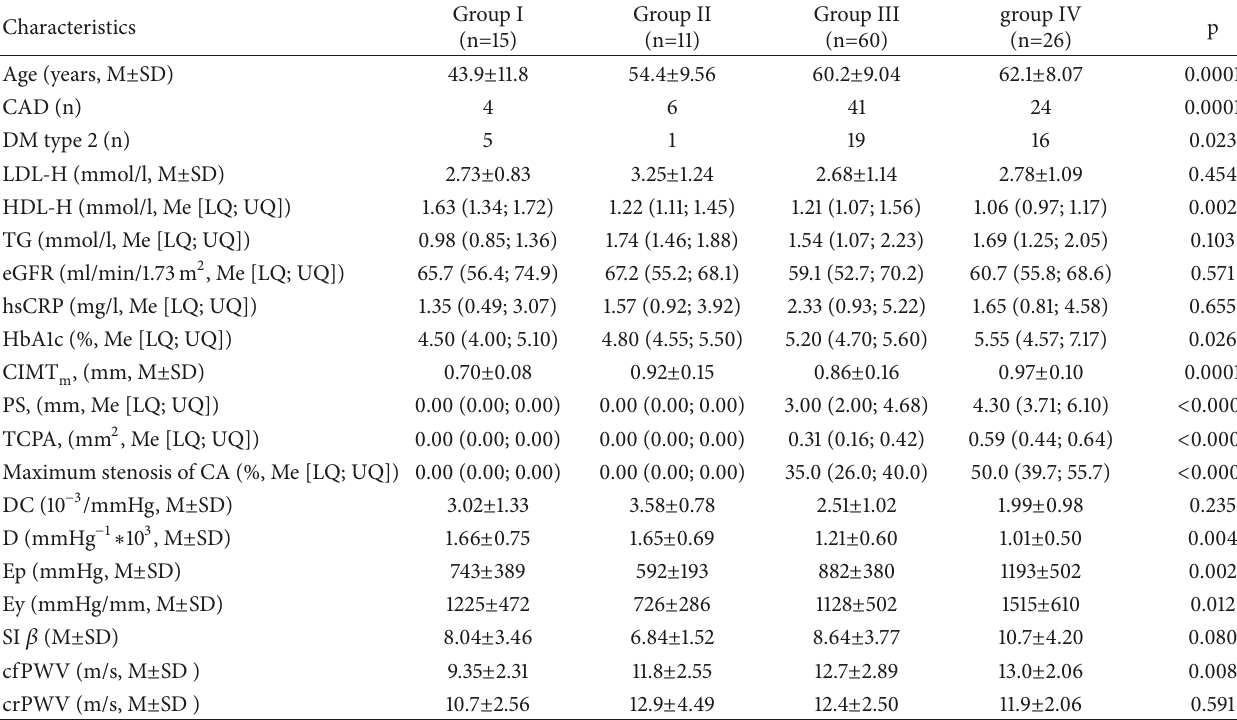
Table 3: Clinical, laboratory, and instrumental characteristics of patients in four groups.